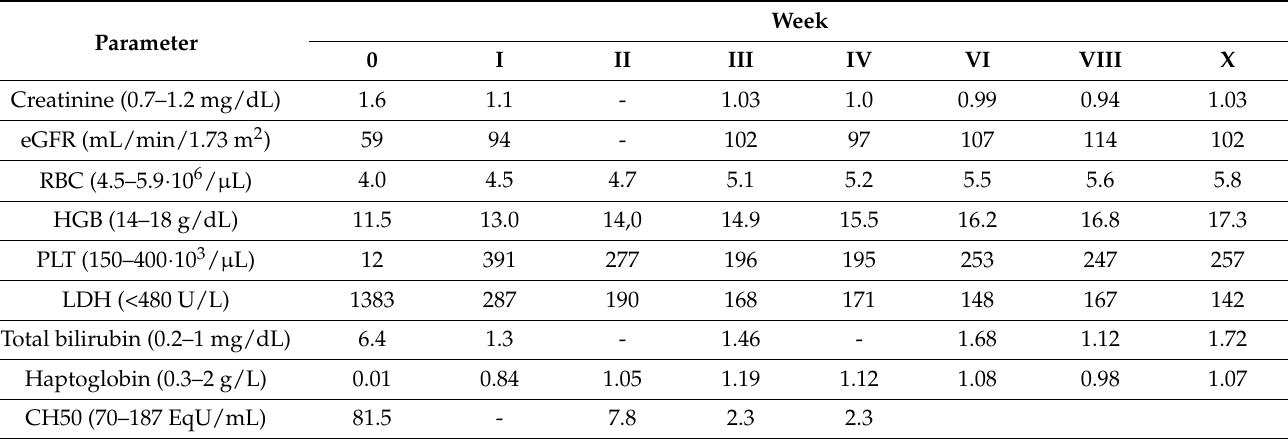
Table 2. Laboratory parameters of patient no. 2 over time after drug